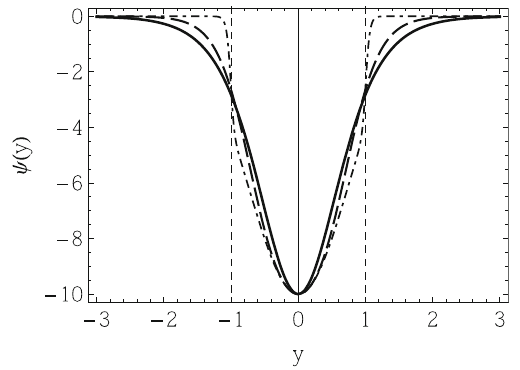
Fig. 9 Plot of ψ( y ) giving by Eq. (35) depicted for ψ 0 = − 1 and n as in Fig.